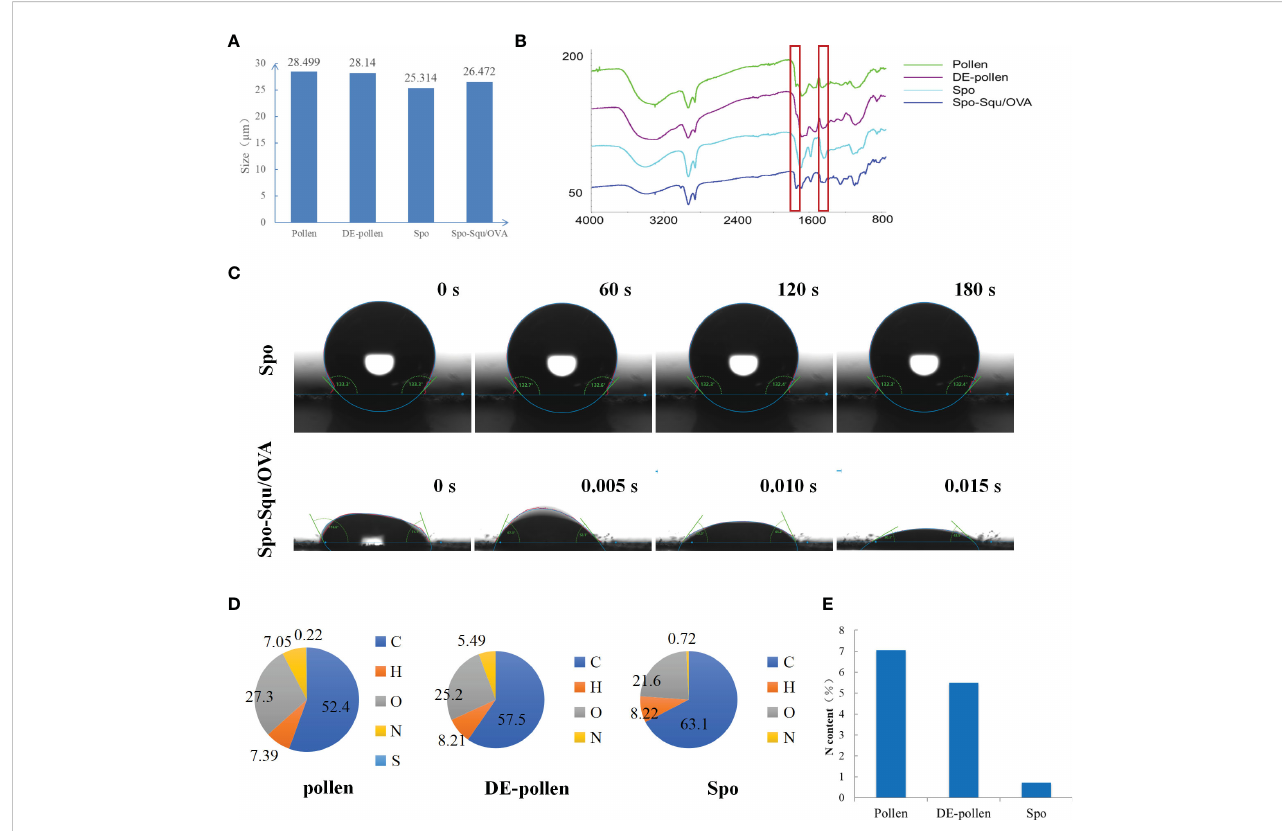
FIGURE 2 The characterization of sporopollenin carrier. (A) grain size patterns and (B) Infrared analysis of Pollen, DE-pollen, Spo and Spo-Squ/OVA. (C) Contact Angle diagram of Spo and Spo Squ/OVA. (D) Chemical composition analysis of pollen, DE-pollen and Spo. (E) The nitrogen content of pollen, DE- pollen and